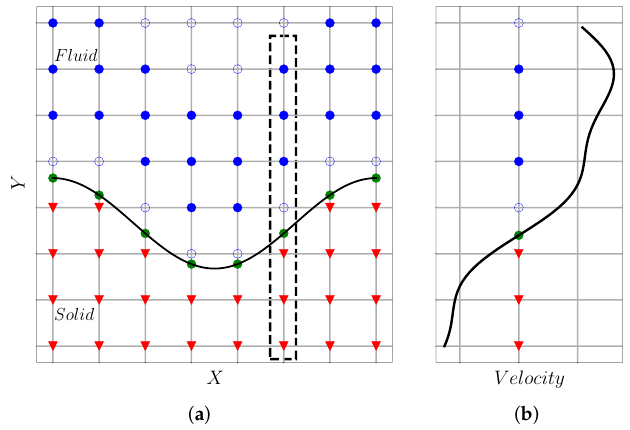
Figure 1. Illustration of 1D polynomial reconstruction based on Lagrangian polynomial. In ( a ), we show the 2D grid distribution with the immersed boundary while ( b ) illustrates the 1D velocity reconstruction along the vertical line enclosed by the dashed rectangle in